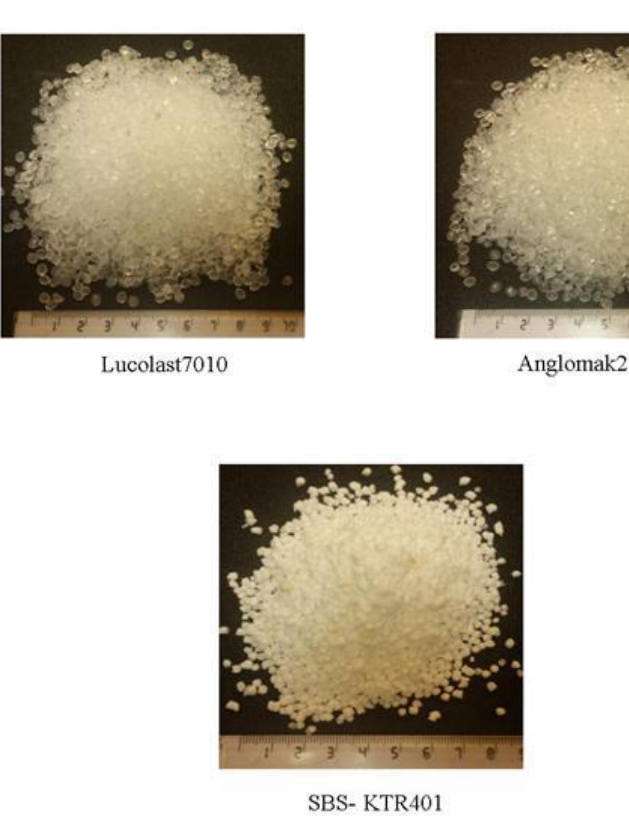
Figure 3. Types of modifiers evaluated. Table 4. Polymer’s properties.